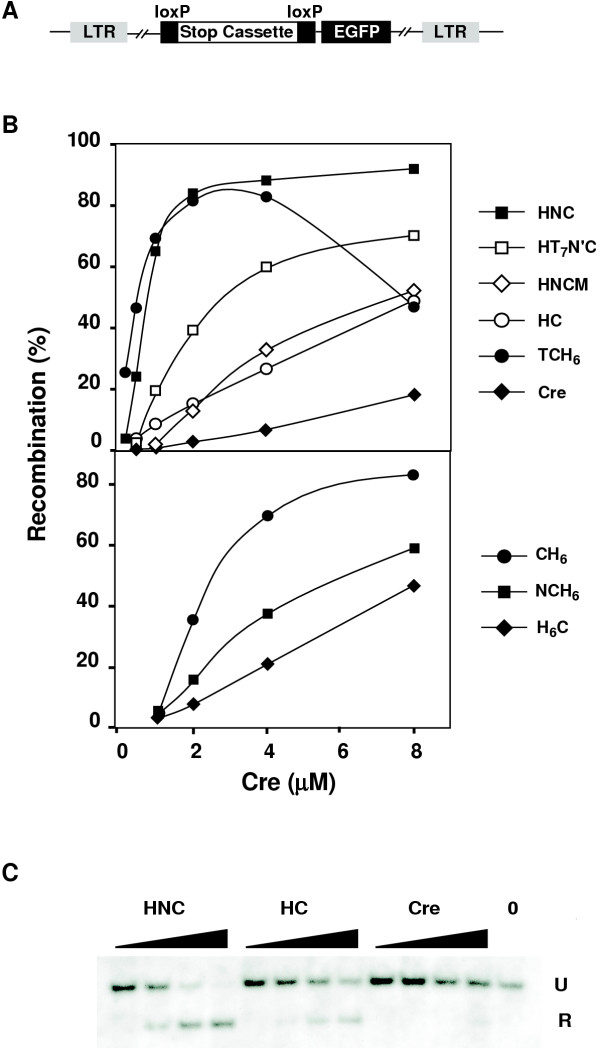
Cre-mediated recombination in cultured cells. (A). Structure of the recombination substrate in Tex.loxP.EG cells. The pBABE.lox.stp.EGFP retrovirus contains multiple polyadenylation sequences (stop cassette) flanked by loxP sites such that Cre-mediated recombination activates the expression of an enhanced green fluorescent protein (EGFP) reporter gene. (B). Dose-response of Cre-mediated recombination. Tex.loxp.EG cells were treated for two hours with increasing concentrations of each soluble Cre recombinase; were washed twice with PBS; and after 24 hours in normal growth medium, the percentage of GFP expressing cells was determined by FACS analysis. For clarity, the results obtained using different fusion proteins are plotted in two panels. The Upper Panel shows results for HNC (solid squares), HT7N'C (solid circles), HNCM (open squares), HC (open circles), and Cre (solid triangles). The Lower Panel plots the results for NCH6 (solid squares), H6C (solid circles), and CH6 (solid triangles). (C). Southern blot analysis of Cre-mediated recombination. Tex.loxp.EG cells were treated with 0.5, 1.0, 2.0, and 4.0 μM of HNC, HNCM and Cre proteins as described above, except after 24 hours DNA was extracted, digested with EcoR1 and analyzed by Southern blot analysis. Cre-mediated recombination results in the conversion of the loxP-containing fragment (upper band, U) to the recombination product (lower band, R).